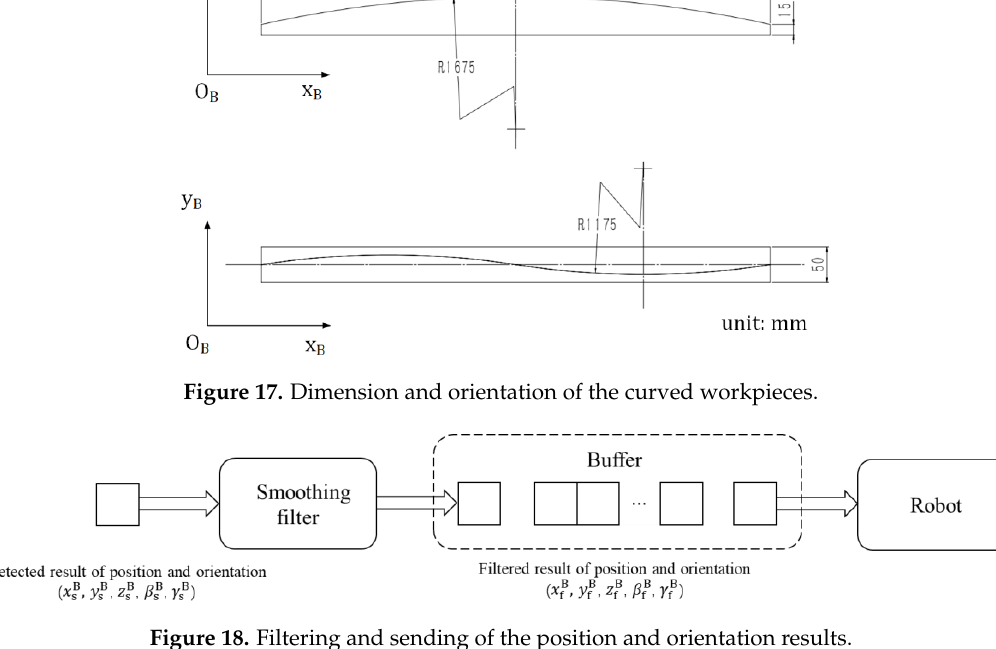
Figure 18. Filtering and sending of the position and orientation results.